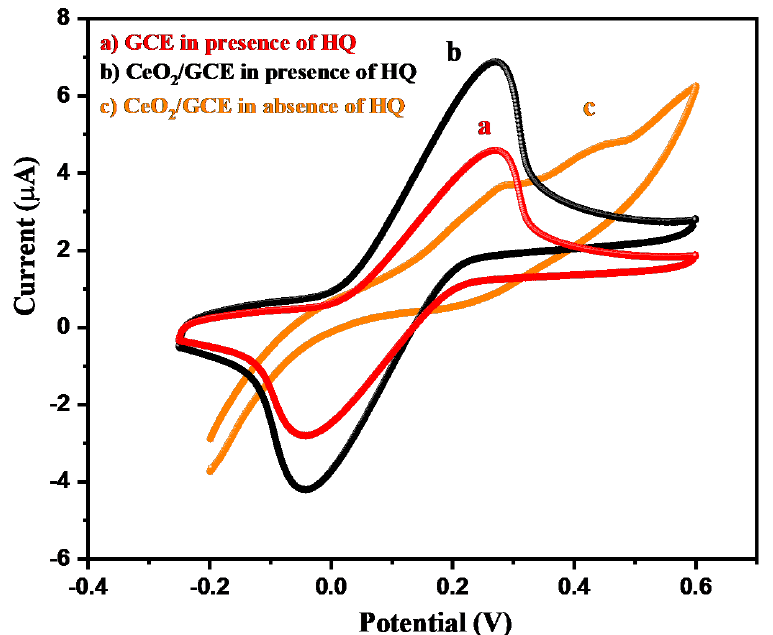
Figure 4. CV graph of GCE ( a ) and CeO 2 /GCE in presence ( b ) and absence ( c ) of 15 µM HQ in 0.1 M PBS of pH 7.0 (applied scan rate = 50 mV/s).